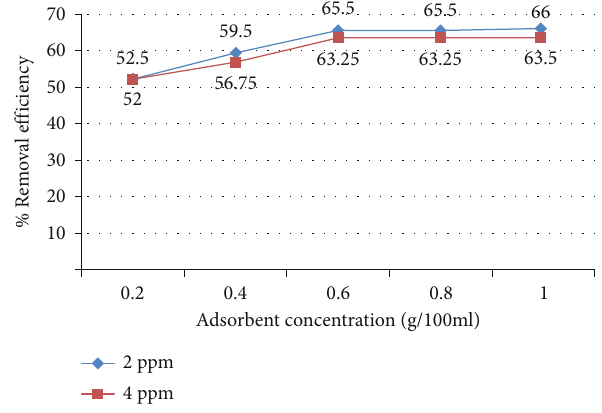
Figure 3: Rice husk powder adsorbent with initial fl uoride concentration 2ppm and